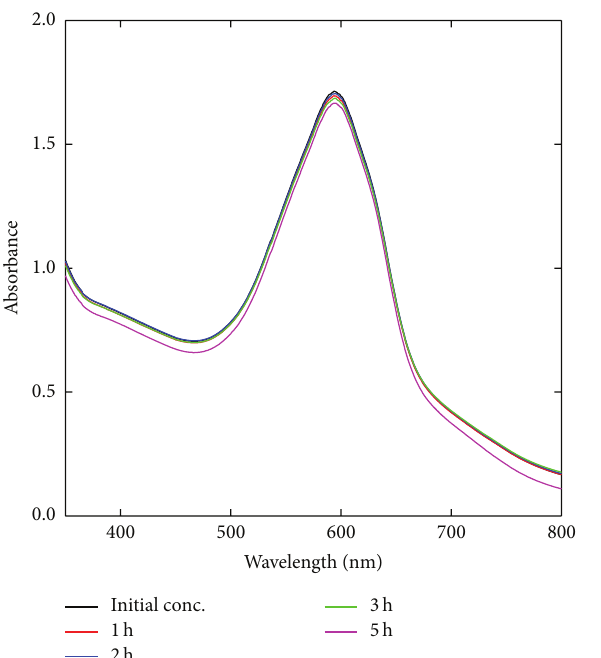
Figure 4: Variation of absorbance of N-719 in terms of adsorption time on TiO 2 thin